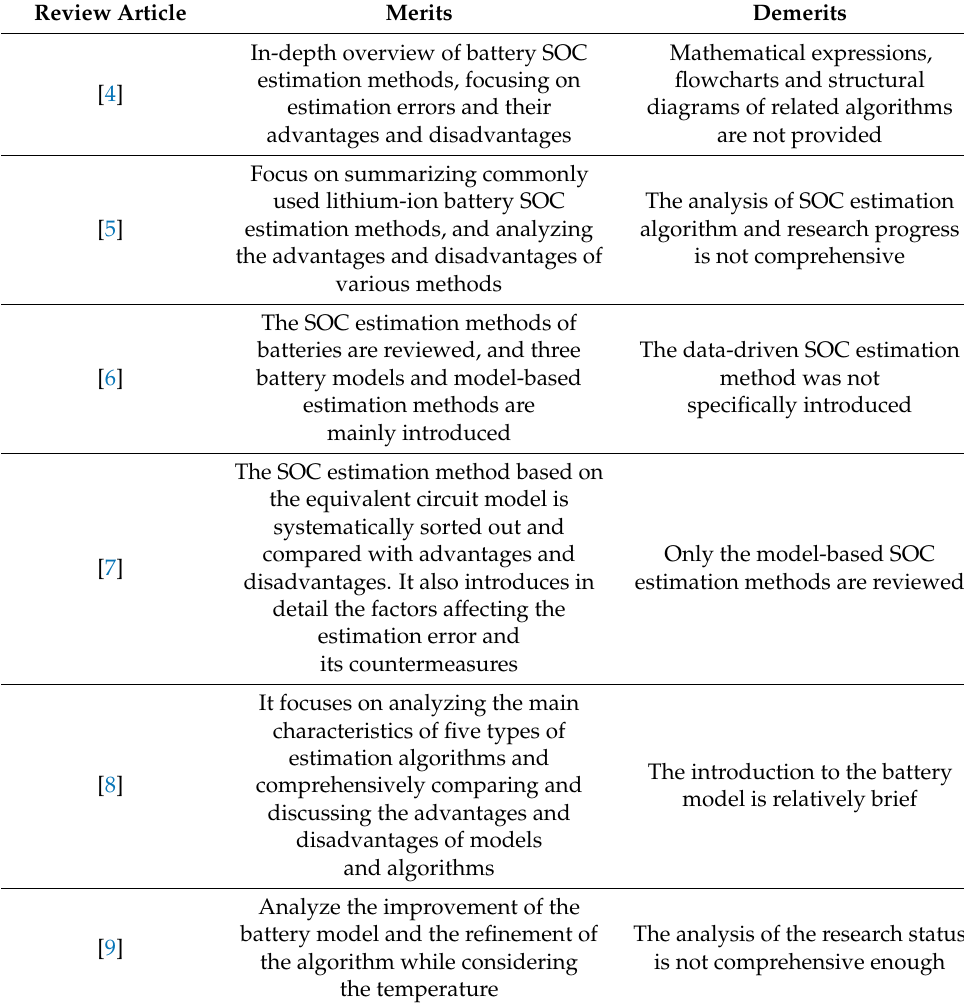
Table 1. Comparison chart of published